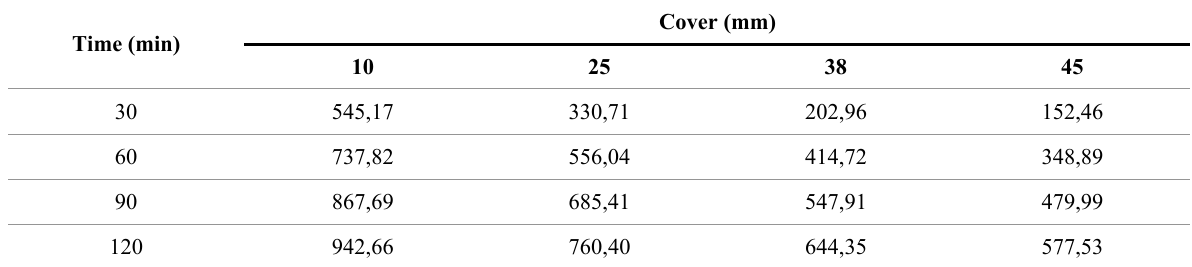
Table 1. Temperature in the steel reinforcement (ºC) in relation to the column cover and the time of exposure to fire.